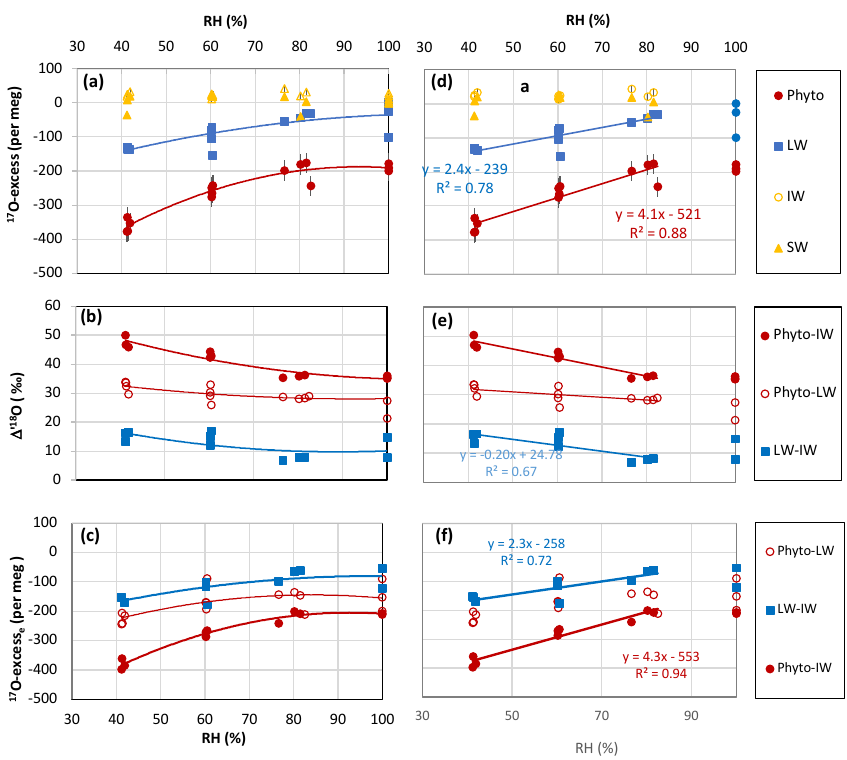
Figure 1. Growth chamber experiment: (a) 17 O-excess vs. relative humidity (RH) of irrigation water (IW), soil water (SW), leaf water (LW) and phytolith (Phyto). Error bars show standard deviation (SD) on the replicates. They are smaller than the symbol when not shown. (b) 18 O- enrichment from irrigation water to leaf water ( (cid:49) (cid:48) 18 O LW − IW ) , from irrigation water to phytolith ( (cid:49) (cid:48) 18 O Phyto − IW ) and from leaf water to phytolith ( (cid:49) (cid:48) 18 O Phyto − LW ) . (c) 17 O-excess associated with the enrichment from irrigation water to leaf water ( 17 O-excess e LW − IW ) , from irrigation water to phytolith ( 17 O-excess e Phyto − IW ) , and from leaf water to phytolith ( 17 O-excess e Phyto − LW ) . (d) , (e) and (f) linear correlations for the 40–80% RH range extracted from (a) , (b) and (c) , respectively.